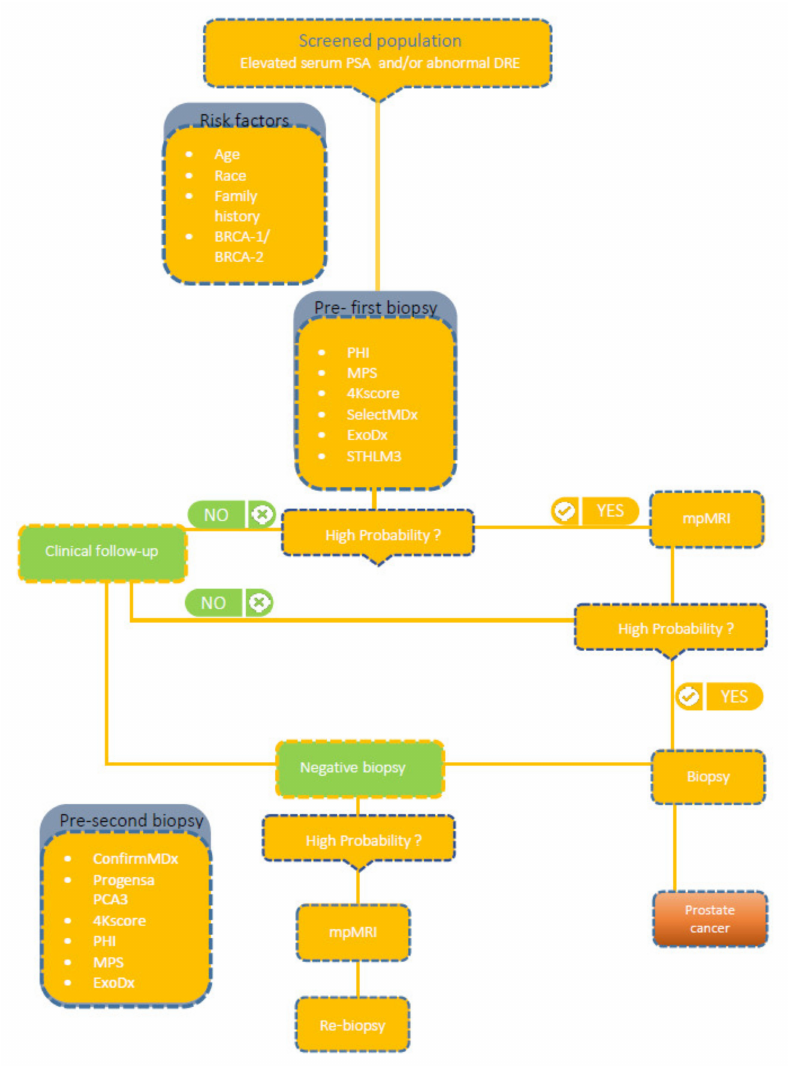
Figure 1. Suggested workflow for utilisation of prostate cancer